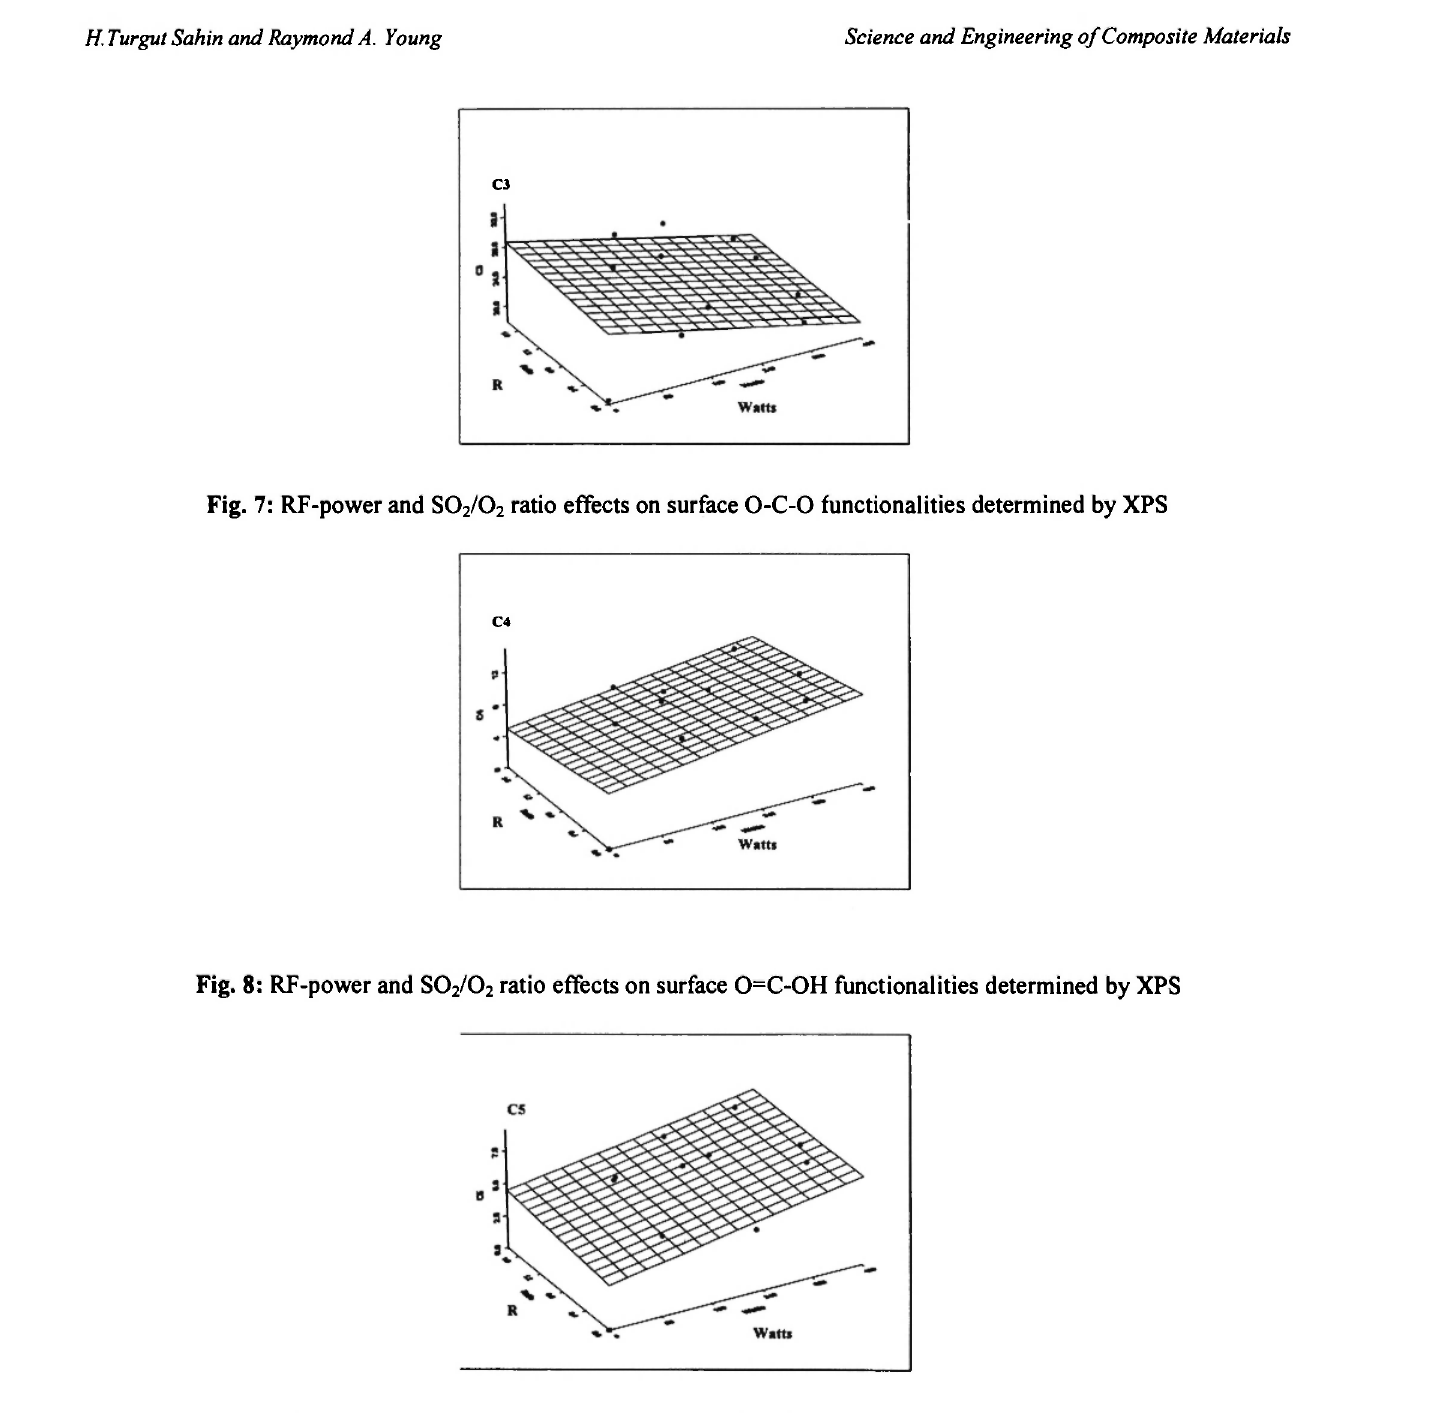
Fig. 9: RF-power and S0 2 /0 2 ratio effects on surface O-CO-O functionalities determined by XPS It is reasonable to conclude that the formation of sulfur and oxygen containing functionalities affect sulfonation as well as intense oxidation, with macromolecular ablation of cellulose. The decreased C-OH surface areas in HR C, s XPS spectra (Table 3 and Fig. 6), verify this assumption. It is well known that the reactive species in a plasma result from ionization, fragmentation, and excitation processes. In reactive gas environment (e.g., S0 2 , 0 2 ) the fiinctionalization with ablation and etching occur simultaneously within the plasma, resulting in the formation of small volatile degradation products /5,